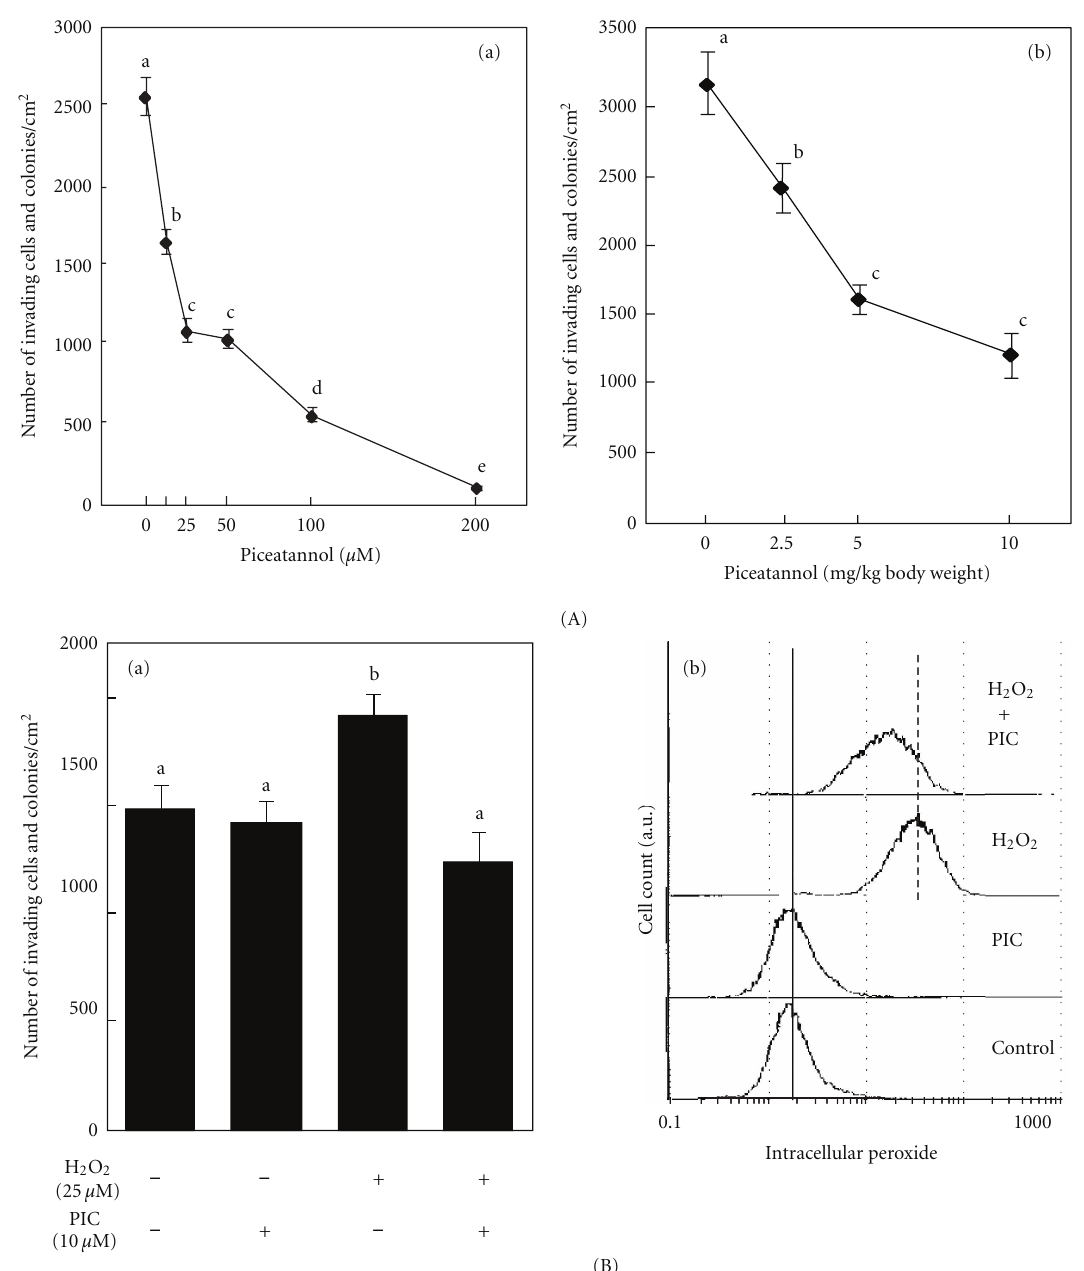
Figure 2: E ff ect of piceatannol on the invasion of AH109A hepatoma cells (A), reactive oxygen species- (ROS-) potentiated invasive activity and intracellular peroxide levels (B). (A) Piceatannol was dissolved in ethanol. The piceatannol solution was added to the culture medium at a final ethanol concentration of 0.2%. Piceatannol was suspended in a 0.3% carboxymethyl cellulose sodium salt (CMC) aqueous solution at concentrations of 0.25, 0.5, and 1mg/mL. Piceatannol suspension or 0.3% CMC alone (vehicle control) (1mL/100 g body weight) was intubated to male Donryu rats which had been fasted overnight, and blood was collected 2h after oral administration. The invasive activity was determined by AH109A-M cell coculture method in vitro (A(a)) and ex vivo (A(b)). Each value represents the mean ± SEM of ten areas. Values not sharing a common letter are significantly di ff erent at P < 0 . 05. (B) AH109A cells were cultured for 4h in the absence or presence of 10 μ M piceatannol with or without 25 μ M hydrogen peroxide (H 2 O 2 ). AH109A cells were then washed once with 10% CS/MEM and seeded on the M-cell monolayer in 10% CS/MEM without piceatannol and ROS. After cultured for 24 h, invaded cells and colonies underneath M-cells were counted with a phase-contrast microscope. Each value represents the mean ± SEM of ten areas. Values not sharing a common letter are significantly di ff erent at P < 0 . 05 (B(a)). To evaluate the e ff ect of piceatannol on intracellular peroxide levels, AH109A cells were treated with 100 μ M H 2 O 2 as ROS source. After ROS treatment for 1 hour, DCFH-DA was added, incubated for 20 minutes, and analyzed with a flow cytometer. Basal and ROS-potentiated intracellular peroxide levels are indicated as solid and dotted lines, respectively. Data are from representative experiment repeated three times with similar results